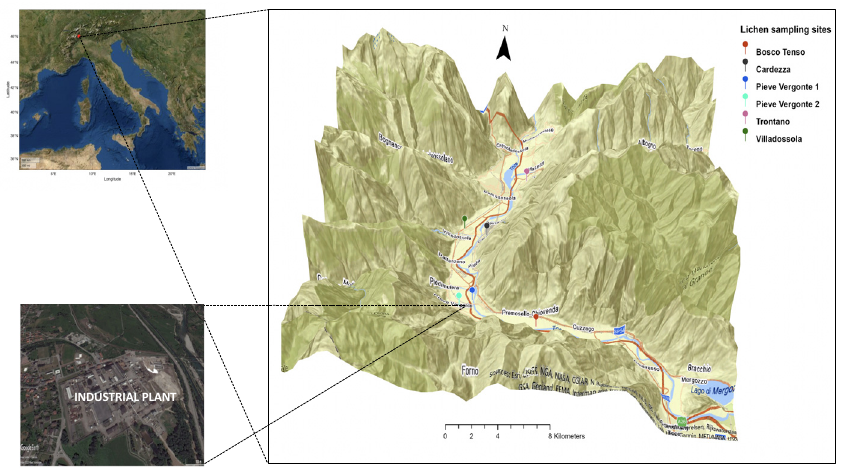
Figure 1. Location of the study